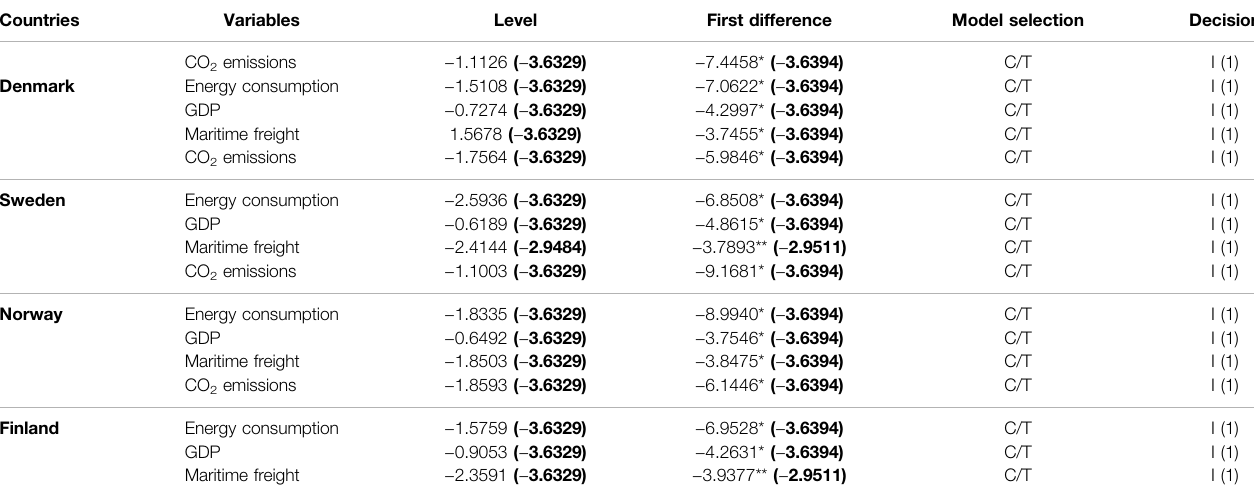
TABLE 3 | Zivot – Andrews unit root test results of Scandinavian countries.